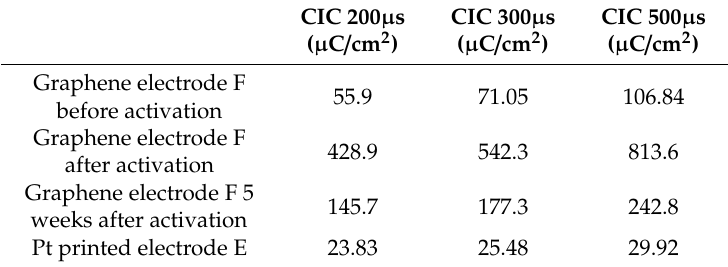
Figure 20. CIC of the graphene electrode F as a function of the pulse width of the stimulation signal. Red line: before the activation; Black line: after the activation. Table 7. CIC of the graphene printed electrode F and Pt printed electrode E for di ff erent values of pulse